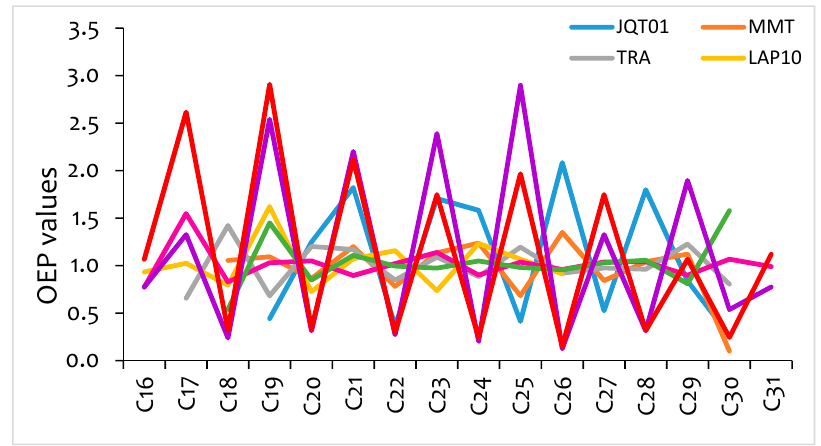
Figure 4. Odd-to-even predominance (OEP) curve of the homologues series of n -alkanes.